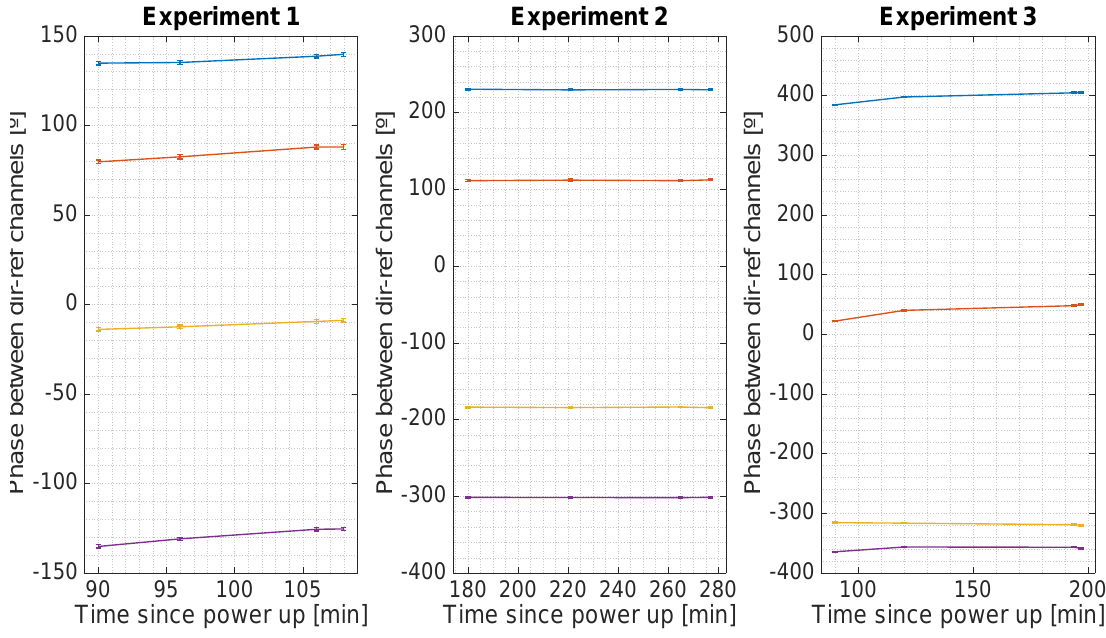
Figure 15. Estimated phase between the direct and reflected RF channels for the four different USRPs during three sets of experiments. The lines show the drift between the estimations, and the markers are error bars.